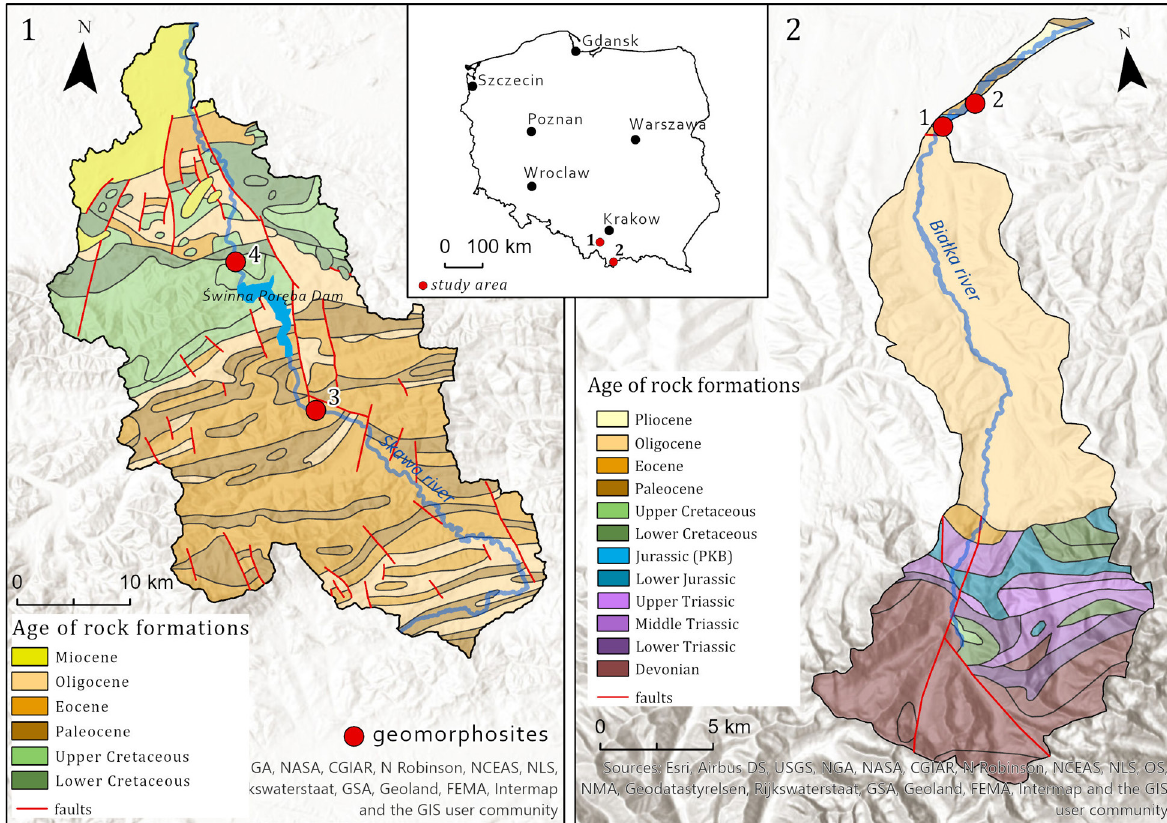
Fig. 2. Geology of the Skawa (1) and Białka (2) riverbeds with the location of geomorphosites. Based on lexa et al.